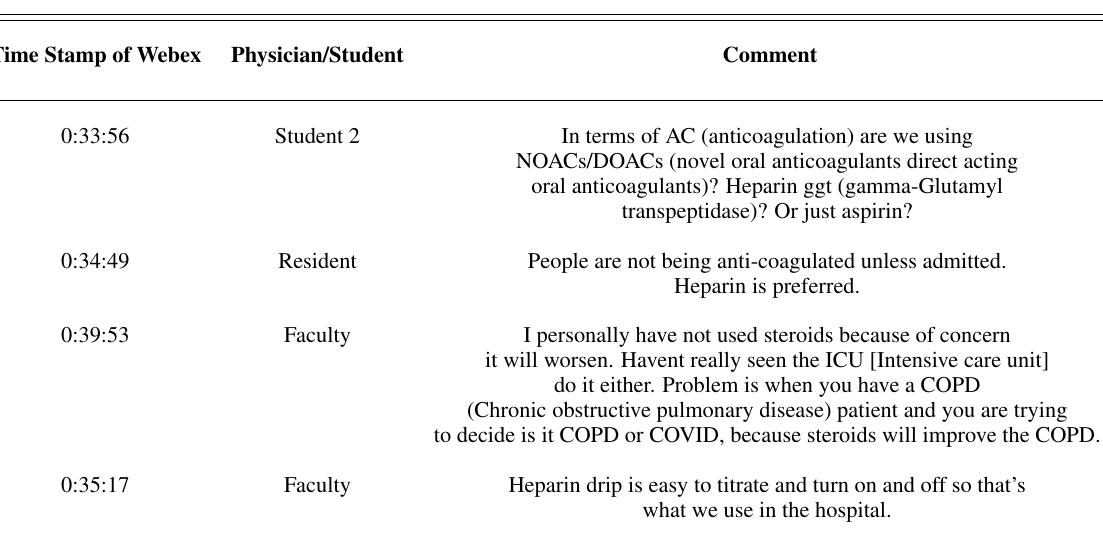
Table 2. Webex chat transcription example